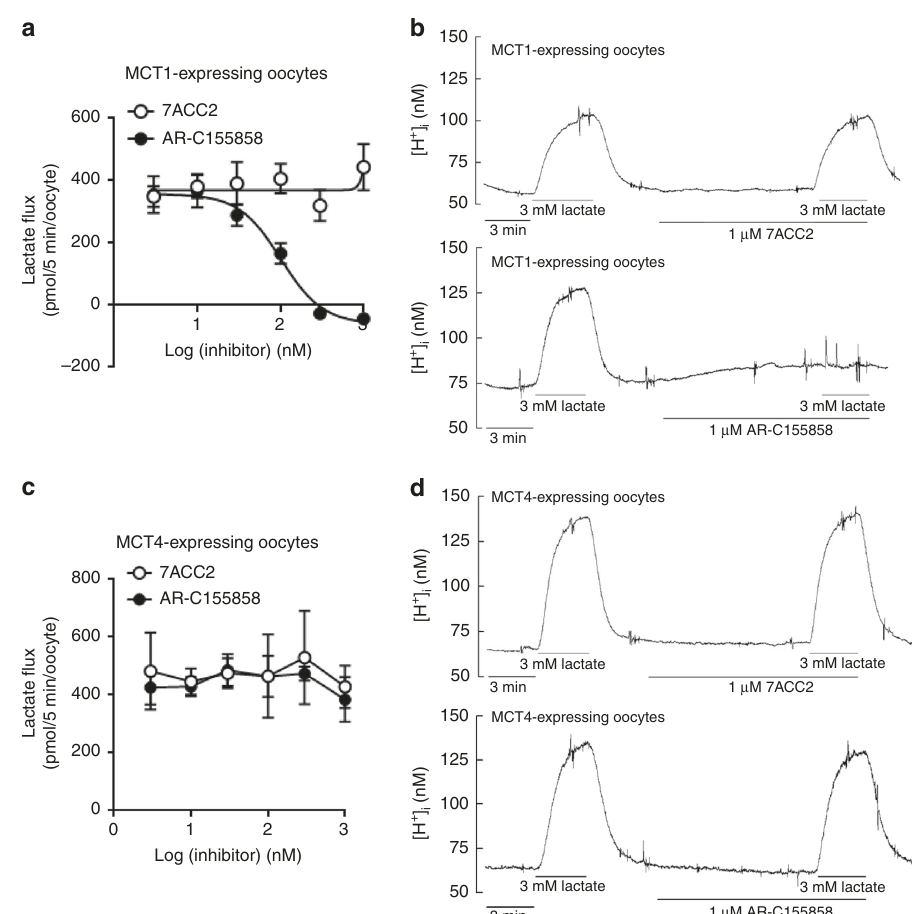
Fig. 2 AR-C155858 but not 7ACC2 inhibits MCT1 activity. a 14 C-lactate uptake in MCT1-expressing Xenopus oocytes after treatment with increasing doses of 7ACC2 or AR-C155858 ( n = 8 for each group). b Original recording of intracellular H + concentration in MCT1-expressing Xenopus oocytes during application and after removal of 3 mM lactate in the absence and presence of 7ACC2 or AR-C155858. c 14 C-lactate uptake and ( d ) intracellular H + concentration in MCT4-expressing Xenopus oocytes in response to 7ACC2 or AR-C155858 treatments ( n = 8 for each group). Data are represented as mean ±